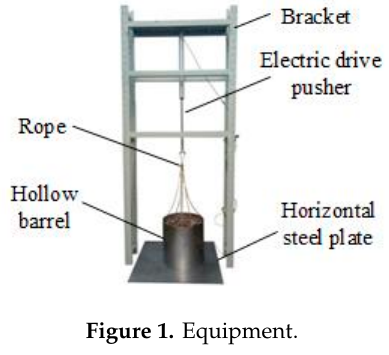
Figure 1. Equipment.